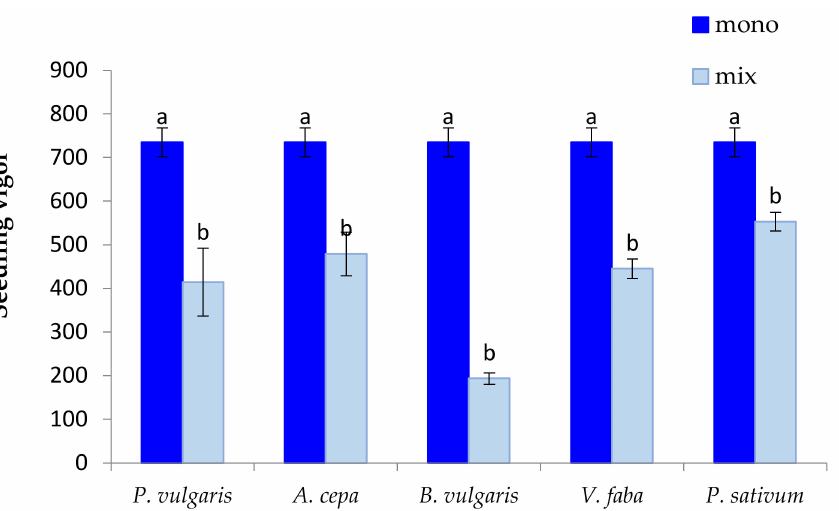
Figure 9. Seedling vigor of P. oleracea grown with crop seeds (mono = weed alone; mix = weed grown together with crop). Bars represent the means of 4 replicates ± SE. Bars topped by the same letter indicate no significant difference between treatments at the 5% level using Duncan’s multiple-range